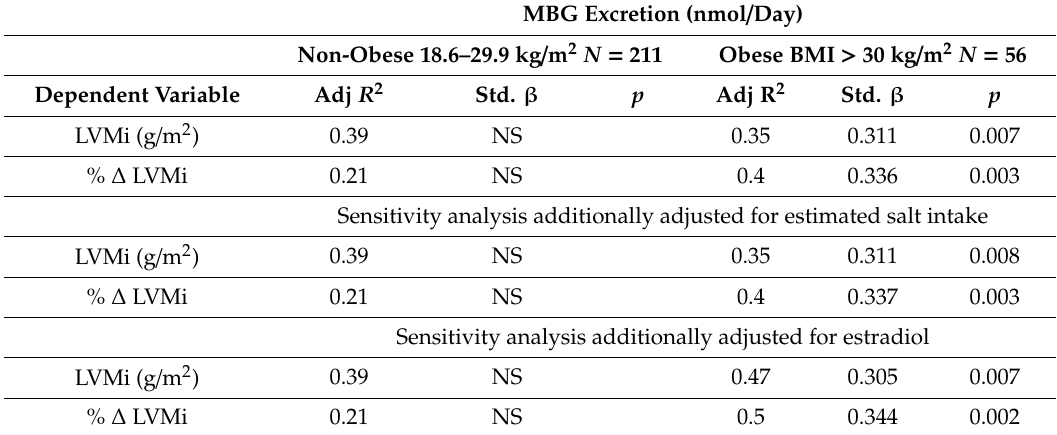
Table 2. Multiple regression analyses with follow-up LVMi and percentage change in LVMi as dependent variables and baseline MBG excretion as the main independent variable.